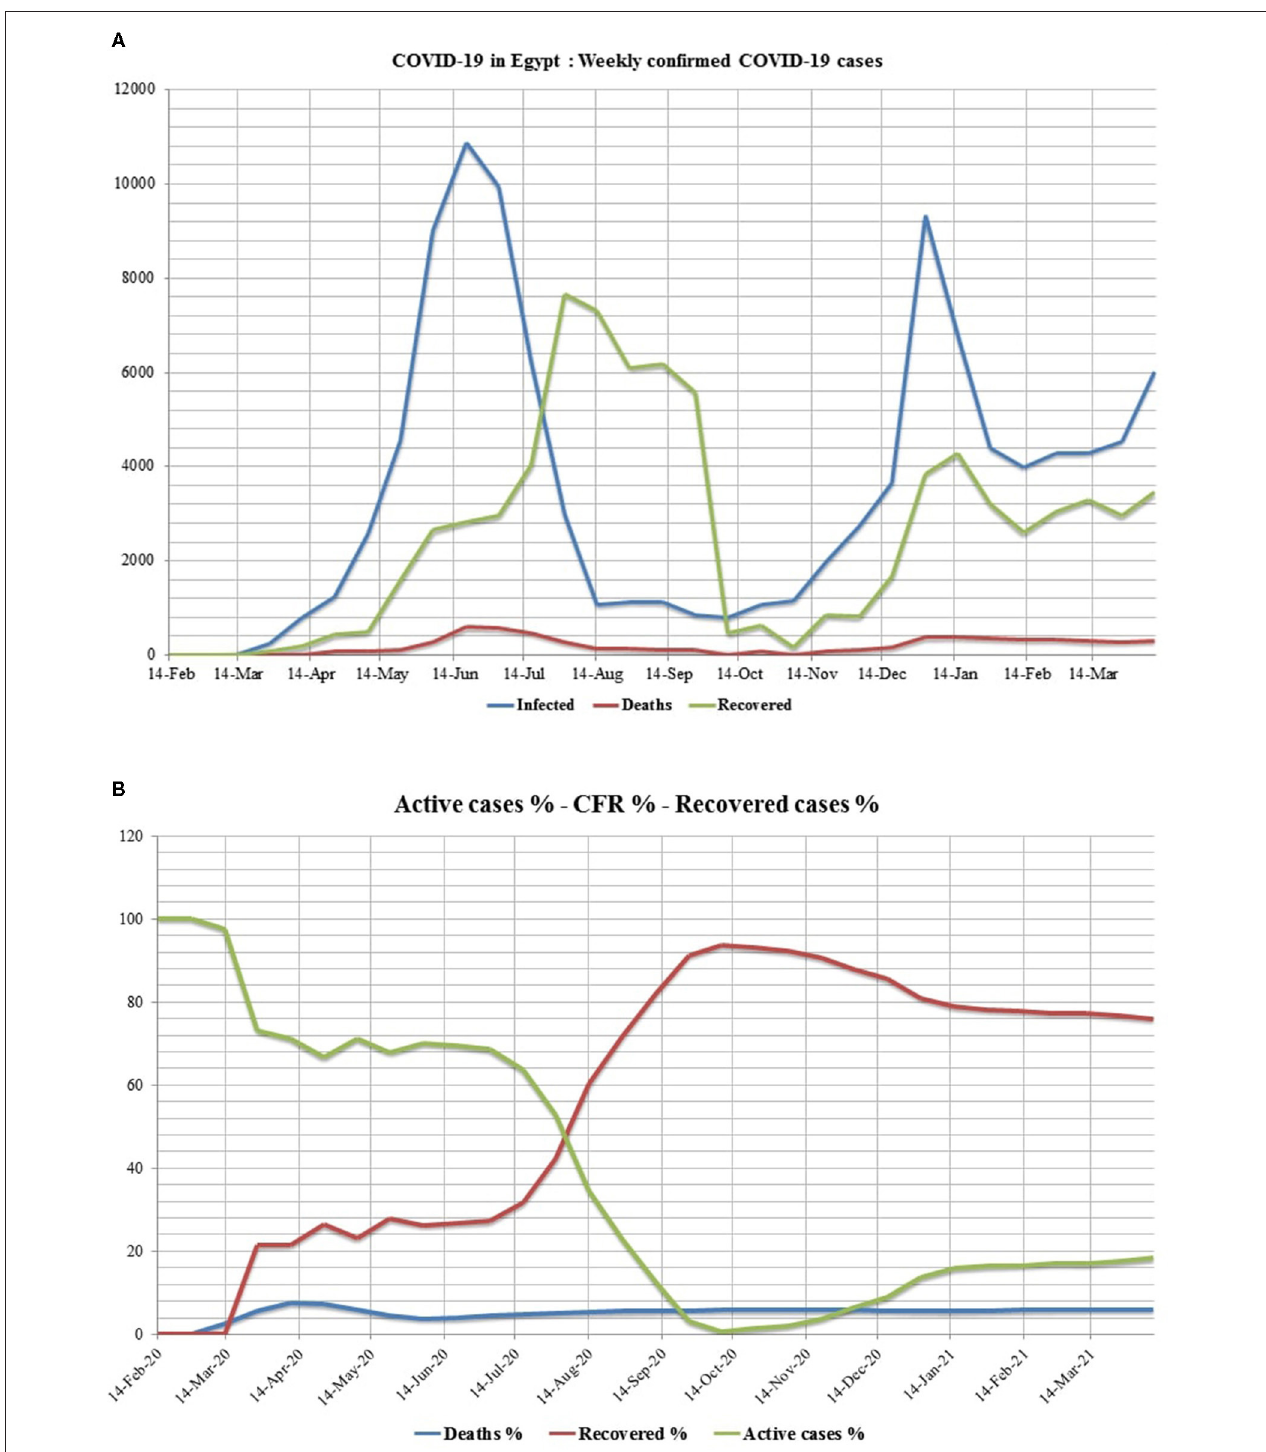
FIGURE 5 | Chart shows (A) the weekly confirmed cases and (B) the weekly percentages of CFR, active cases, and recovery. The chart of the weekly confirmed cases showed the first and second waves in June and December 2020, respectively. The highest percentage of recovered cases was found in August 2020, while the lowest was found in November 2020. The death rate is correlated with the waves, but it was higher in the first wave. The charts of weekly percentages showed that the percentage of active cases started with the first confirmed case in Egypt (February 14, 2020) while the percentage of death rate started with the first death (8 March). The lowest percentage of active cases was recorded in October 2020, when the percentage of recovered cases was the highest.